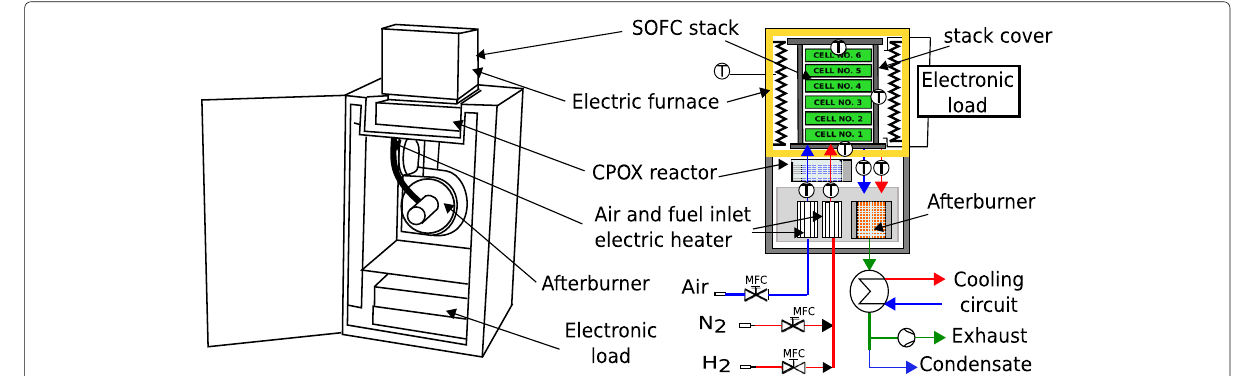
Fig. 2 A schematic view on the Modular Stack Test